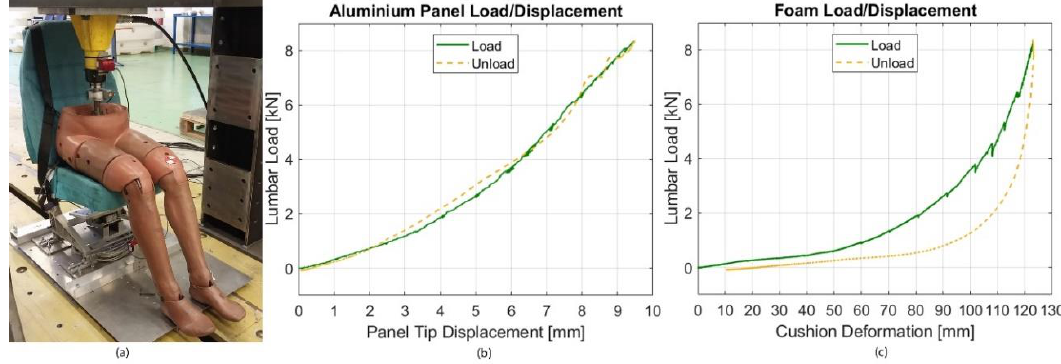
Figure 7. Seat pan stiffness test: ( a ) test set-up with hydraulic cylinder applying the load on the pelvis; ( b ) seat pan tip load–deflection; ( c ) foam load–deflection